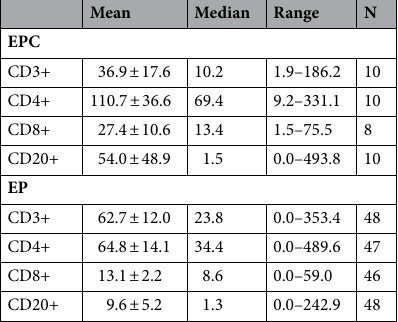
Table 3. Density of each lymphocyte type (DAB+ cells/mm 2 ).